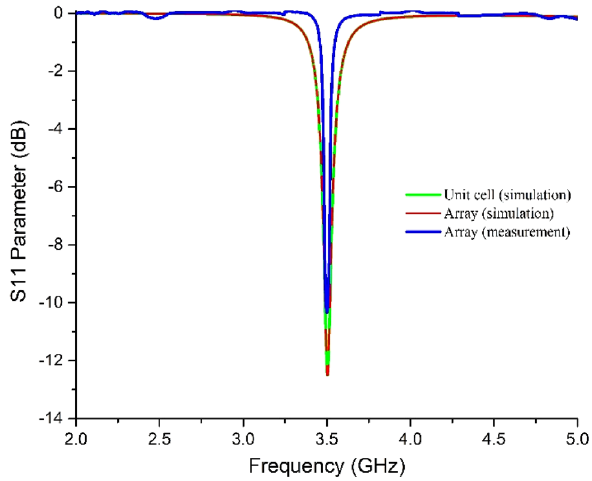
Figure 11. Comparison of S 11 parameter (dB) by simulation and measurement.